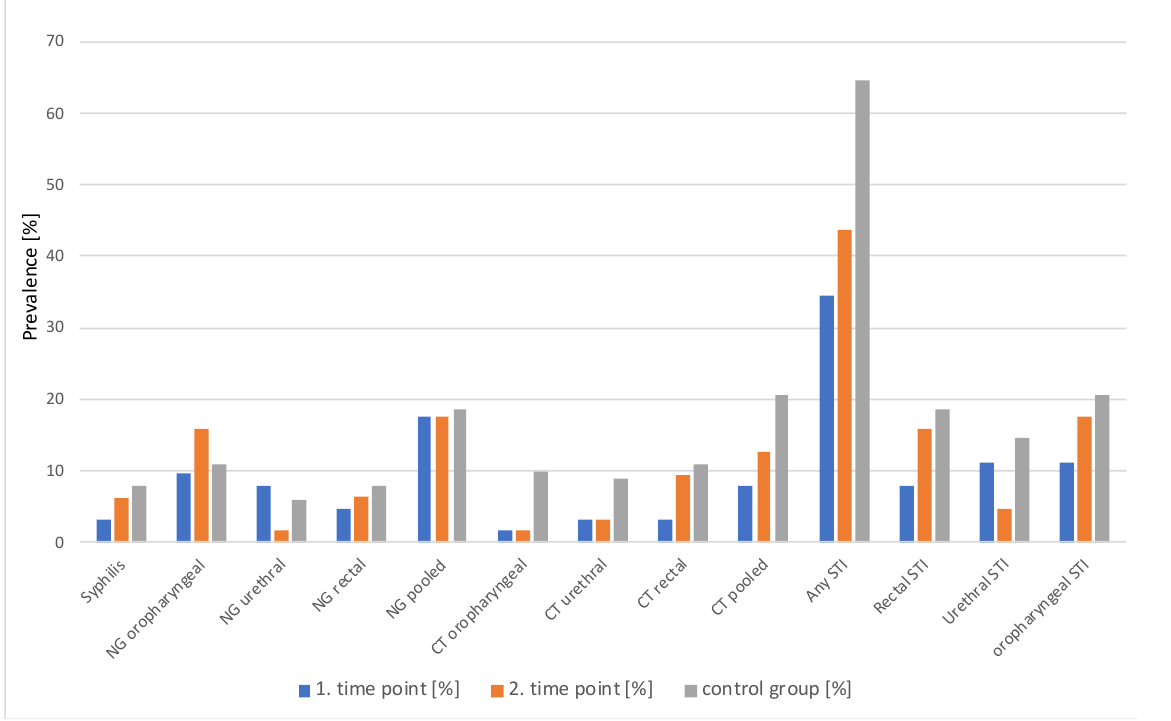
Figure 1. STI prevalence by group, timepoint and anatomical site. Although CT infections seemed to be more common in the control group and oropharyngeal NG at the second time point, no statistically significant differences were observed, irrespective of whether the sites of infection were analyzed separately or pooled between time points (McNemara test) or between groups (Fisher test). Even when all HIV, HCV, syphilis, NG, and CT infections were pooled together, there was no difference in prevalence between groups or time points (see Table 3).